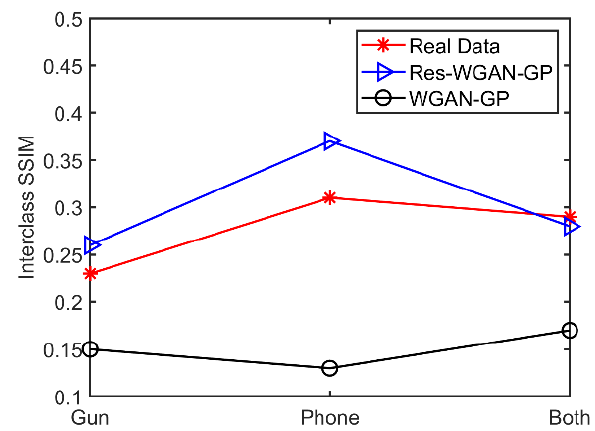
Figure 9. Diversity evaluation by interclass SSIM.